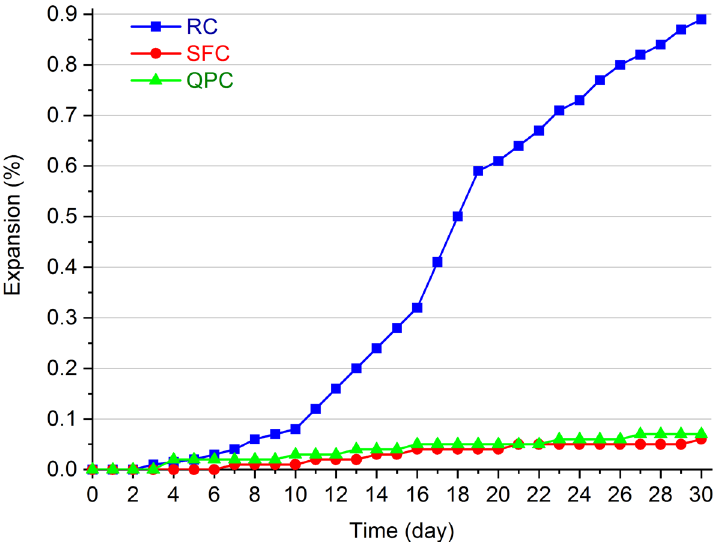
Figure 11. Expansion by alkali-aggregate reactions using the mortar-bar method in the RC, SFC and